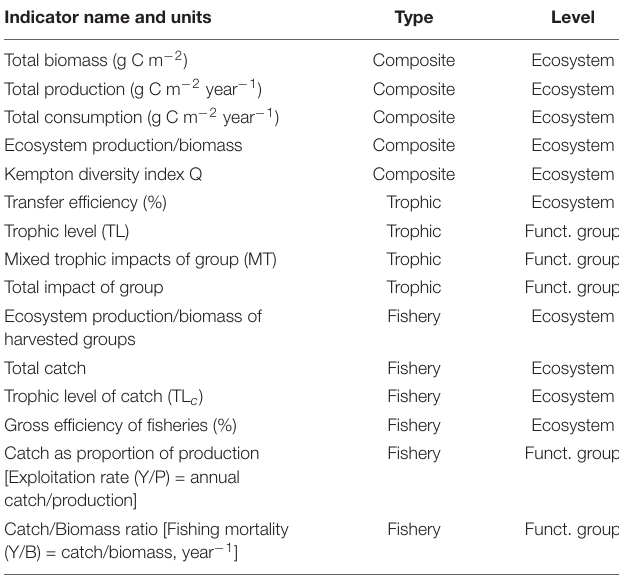
TABLE 2 | List of indicators at ecosystem and functional group